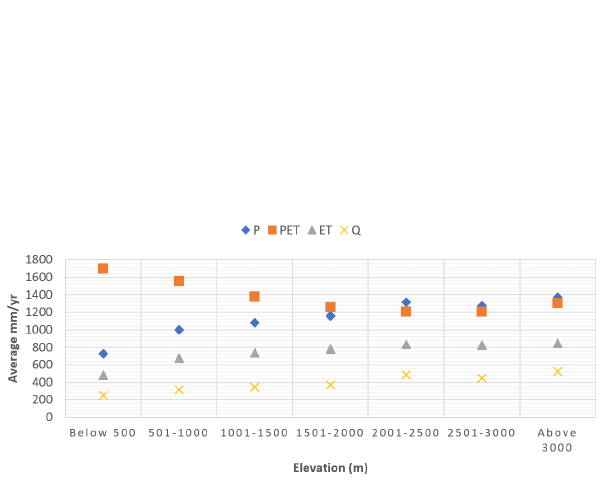
Figure A4. The impact of elevation on hydroclimatic conditions in the East African